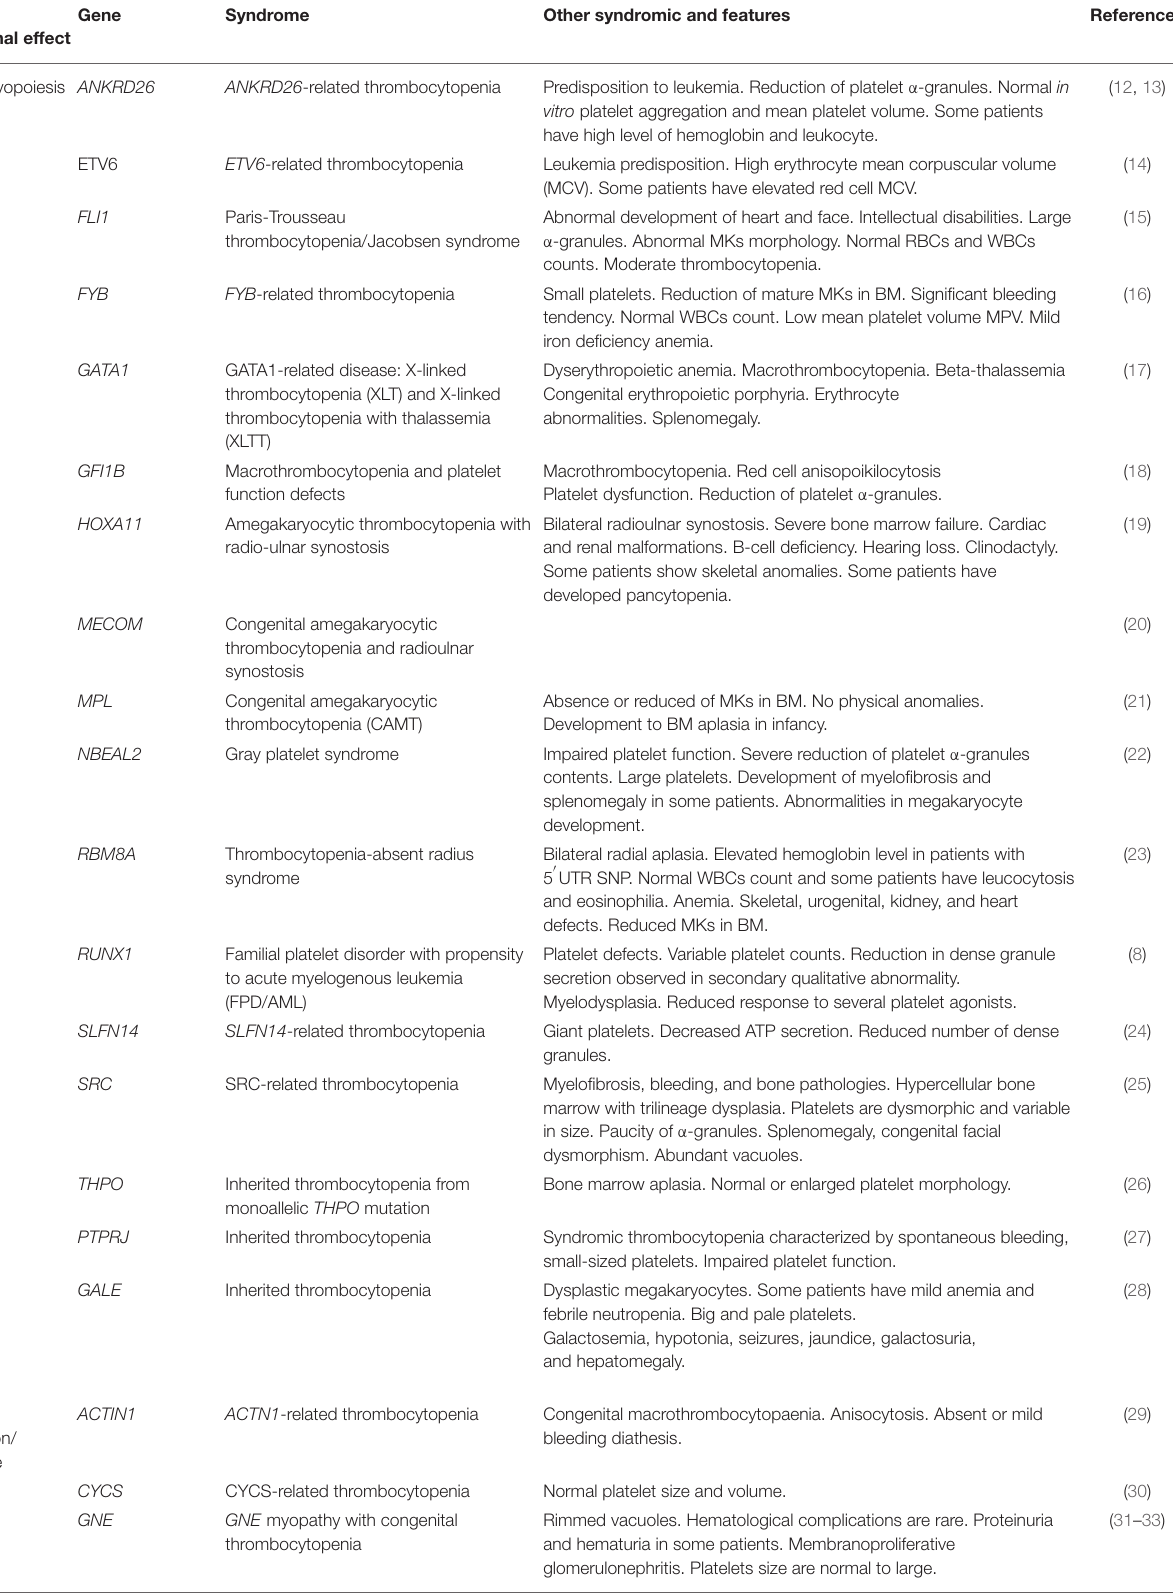
TABLE 1 | The direct genetic causes of inherited thrombocytopenia and their associated